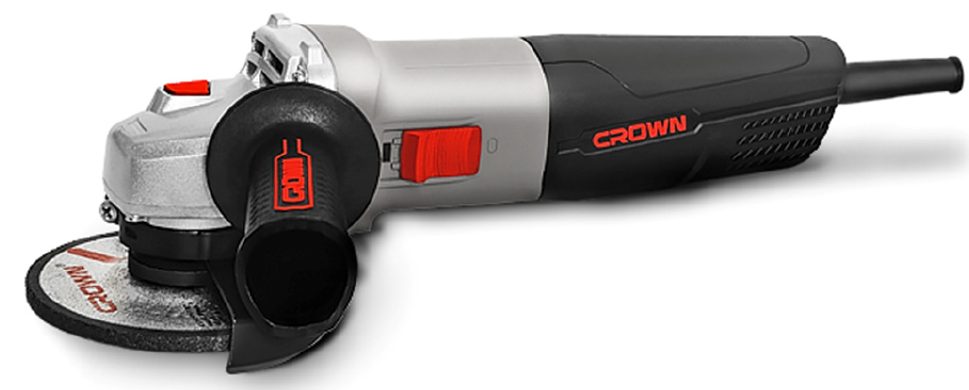
Figure 2. The angle grinder CT13499 − 115.